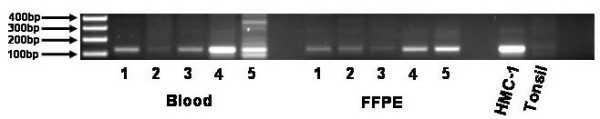
Detection of point mutation Asp 816 to Val in blood or FFPE samples. Blood FFPE. Lane 1: 35 ng template 25 ng template. Lane 2: 190 ng template 20 ng template. Lane 3: 189 ng template 224 ng template. Lane 4: 205 ng template 186 ng template. Lane 5: 296 ng template 125 ng template. HMC-1, tonsil (200 ng).